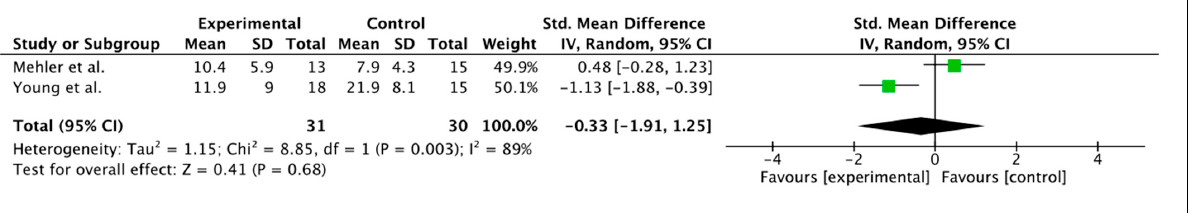
Figure 5. Forest plot. Difference in depression severity clinical scores from baseline to follow-up. The